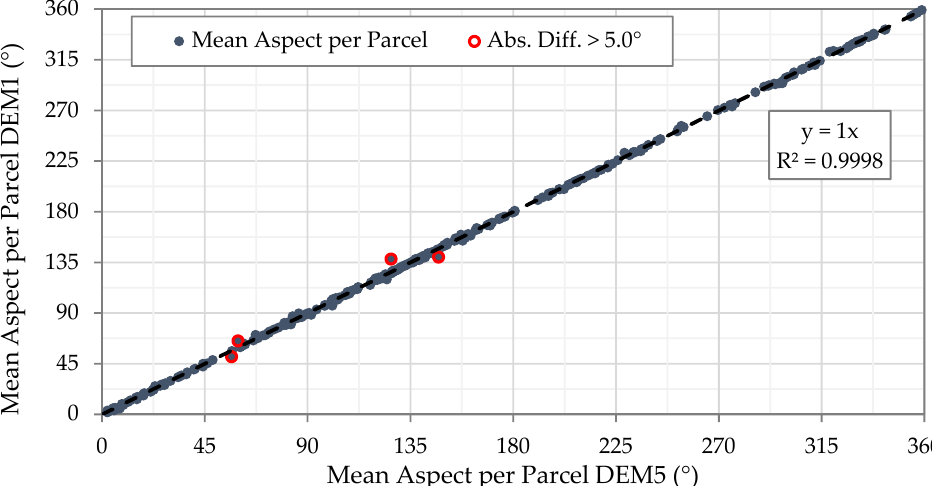
Figure 12. Comparison of mean aspect per arable parcel for DEM1 and DEM5. Red points indicate an absolute difference greater than 5.0°; data source: [30,40].